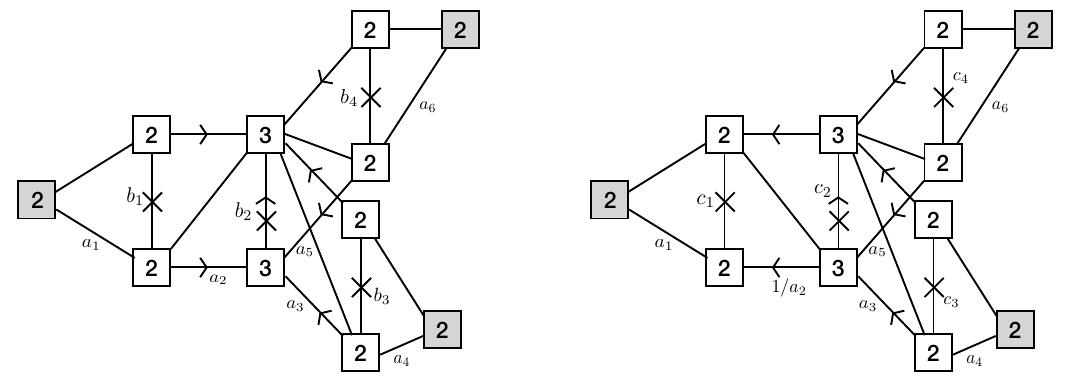
Figure 15 . Basic domain walls in the minimal E 6 theory with D 1 = f + 6 g (cid:12) and D 2 = f + ; (cid:0) ; + 4 g (cid:12) , respectively. The shaded boxes stand for SU(2) 3 (cid:13)avor nodes in the bulk 5d